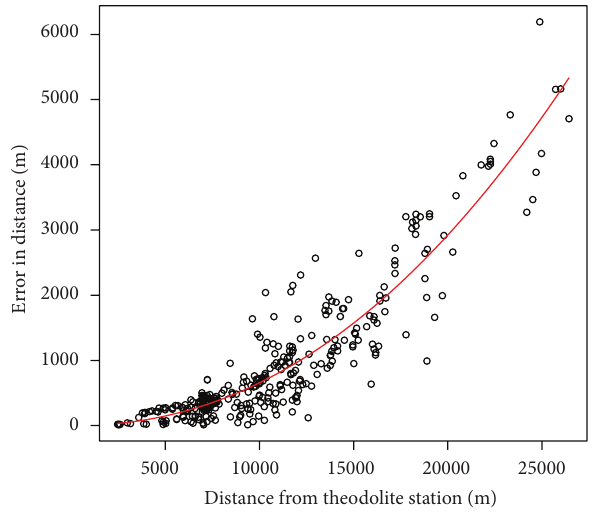
Figure 5: Error in measurements of distance between theodolite fixes and GPS positions. Red line: best fitting curve ( 𝑦 ∼ 𝑎 ∗ 𝑥 ∧ 𝑏 ).